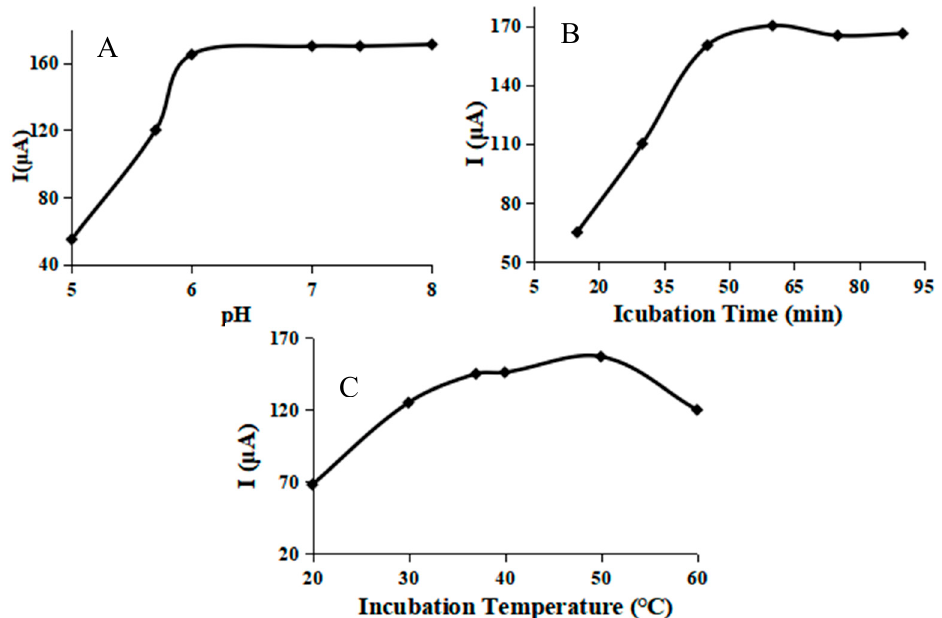
Figure 5. The CV peak current values of different horseradish peroxidase-labeled ampicillin (HRP-AMP) concentrations.